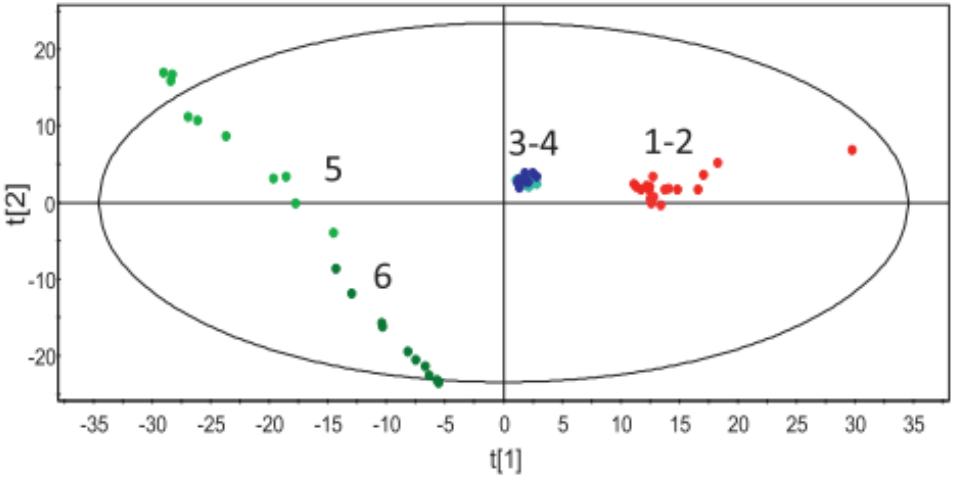
Figure 2. Scores scatterplot for in-line Raman spectra recorded at different temperatures. (Reproduced with permission from Almeida et al., International journal of pharmaceutics; published by Elsevier, 2013) [70].